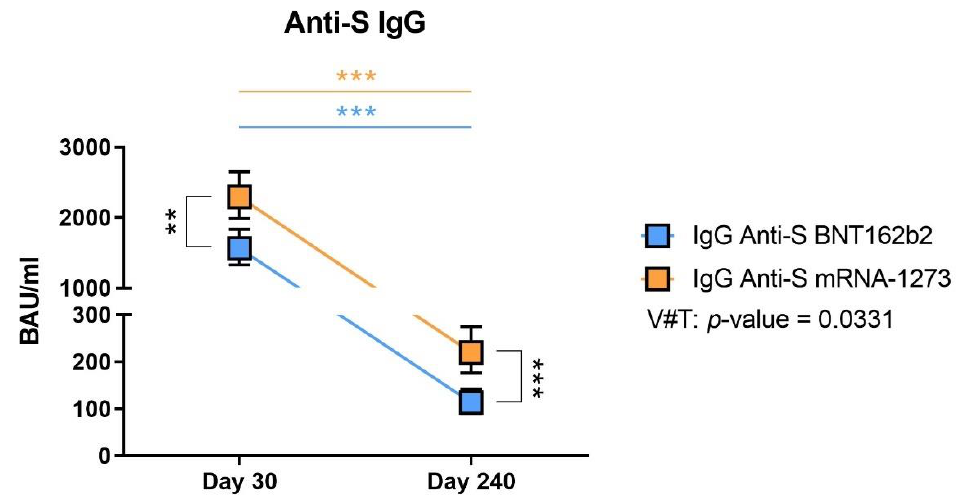
Figure 1. Anti-S IgG levels on day 30 and 240 post-vaccination and predicted evolution of the values. The estimated means and confidence intervals were calculated by a multiple linear regression model, adjusted by age and gender and with Bonferroni correction. Squares represent the mean and confidence intervals for anti-S IgG BAU/mL at days 30 and 240, for BNT162b2 (in blue) and mRNA- 1273 (in orange). The evolution of anti-S IgG values was calculated using the mixed-effects model. V#T indicates the interaction between the type of vaccine and the time evolution. ** p -value < 0.01. *** p -value < 0.001.